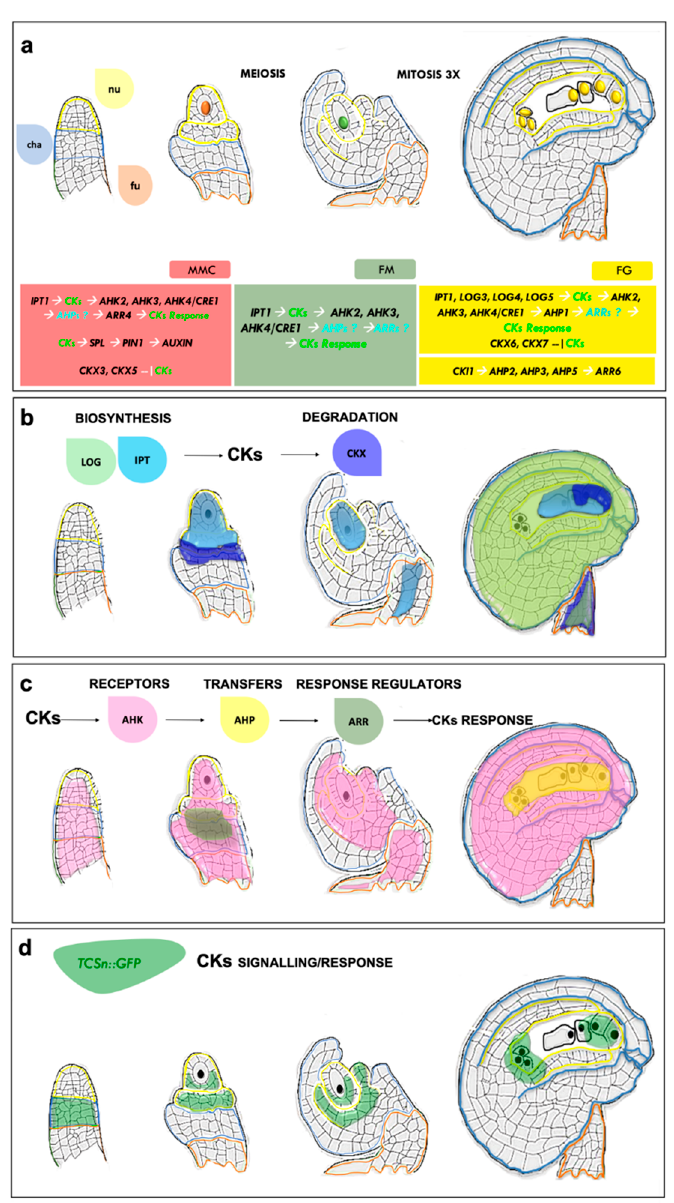
Figure 2. The expression domains of CKs-related genes during ovule development. CKs biosynthesis, degradation and signalling components expression domains and their hypothetical relationships. ( a ) Cartoon of the distinct and sequential phases of ovule development in Arabidopsis, first finger-like structure with three different zones outlined nucella, chalaza and funiculus, then ovule primordium with a megaspore mother cell (MMC) differentiated that enters in meiosis forming the functional